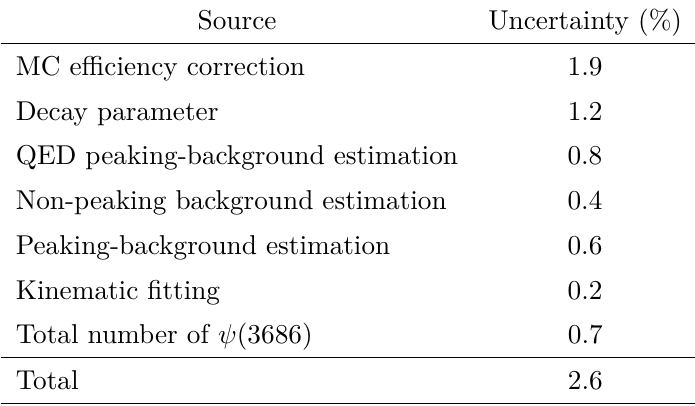
Table 2 . Systematic uncertainties on the branching fraction measurement